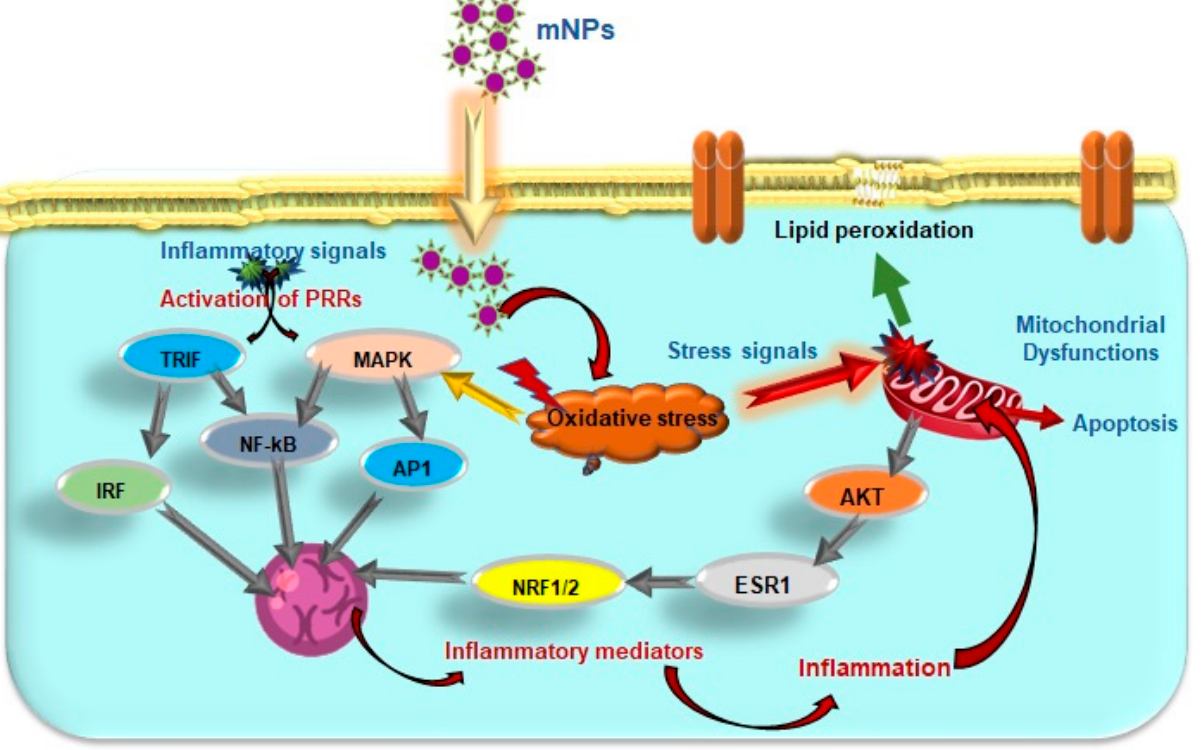
Figure 5. Cellular pathways connecting excess ROS production, oxidative stress and inflammation. The activated PRRs trigger downstream signalling pathways and activate transcription factors. (Im- age source: mitochondria and nucleus images from brgfx on Freepik).